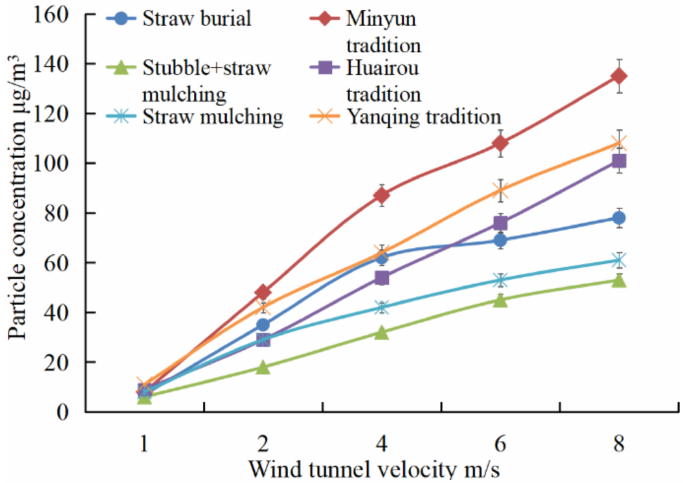
Figure 25. PM2.5 concentration changes with wind speed at 10 cm height in the wind tunnel.